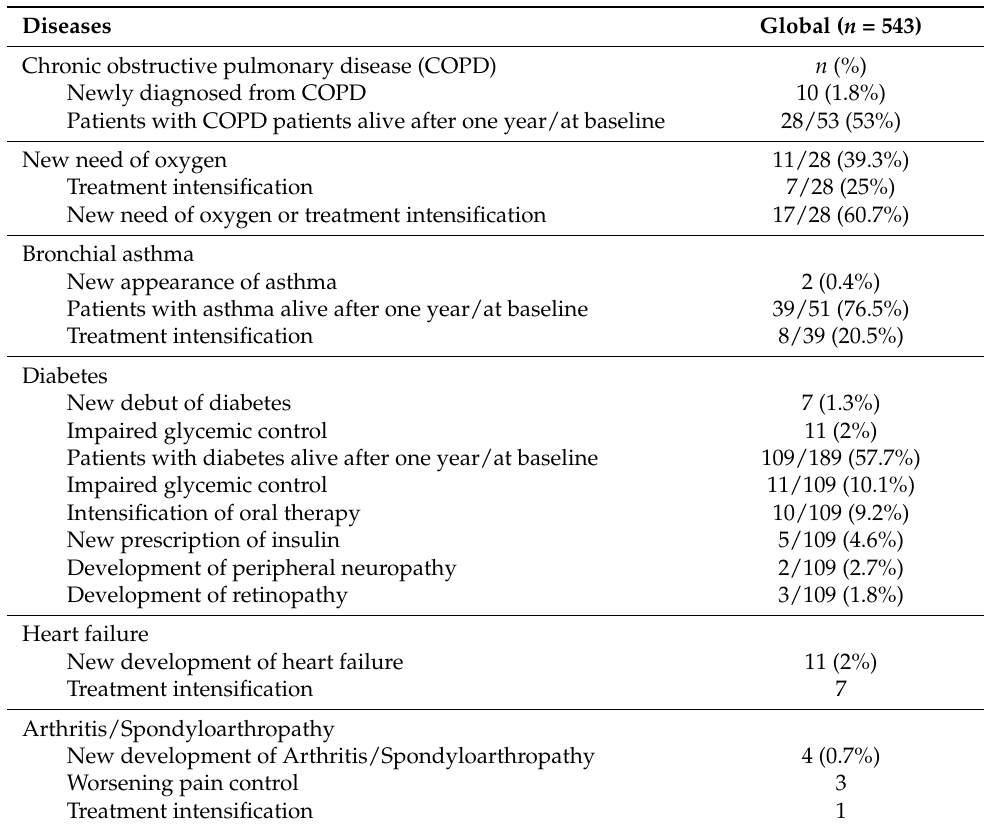
Table 3. Clinical worsening and new onset of concomitant diseases reported by patients after one year of recovery from acute